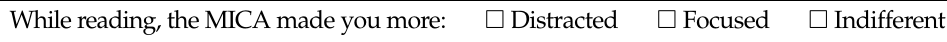
Table 2. Question asked to the